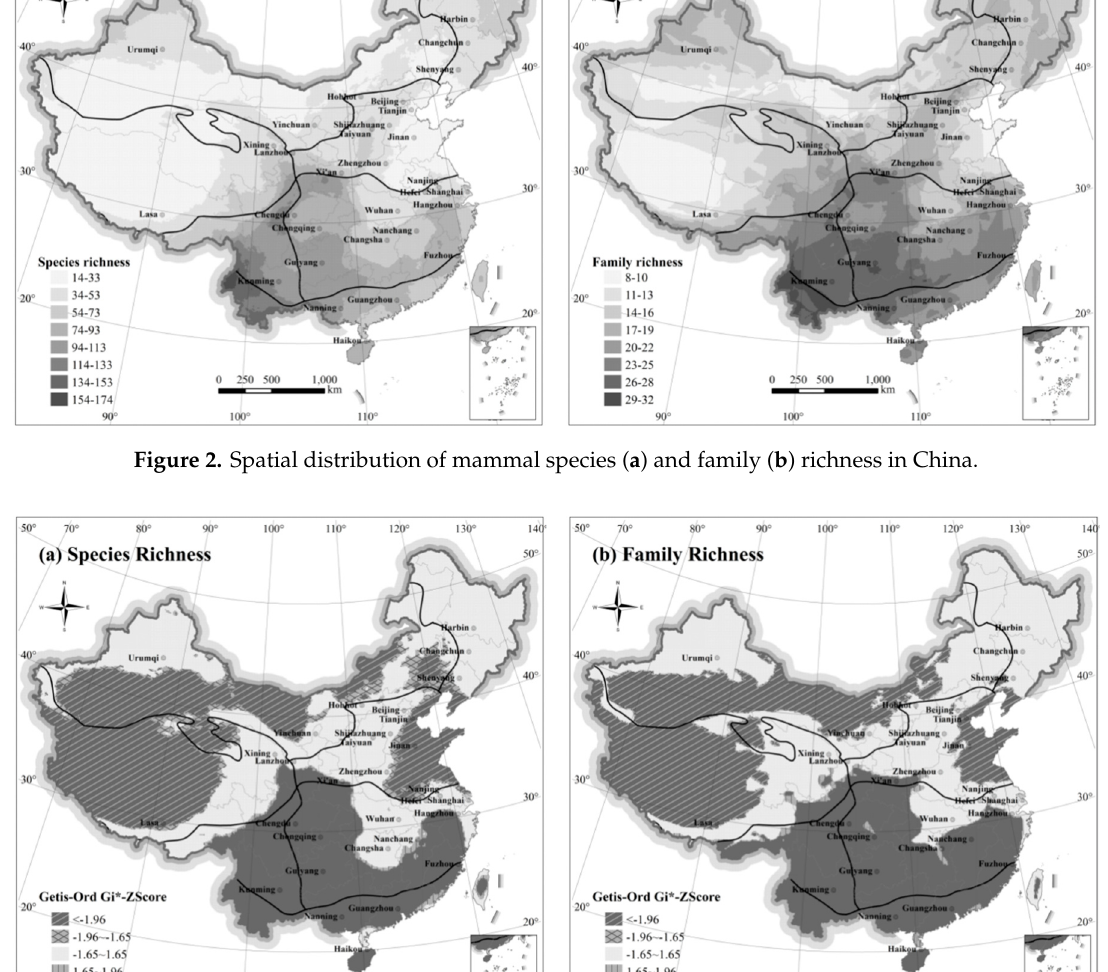
Figure 2. Spatial distribution of mammal species ( a ) and family ( b ) richness in China.